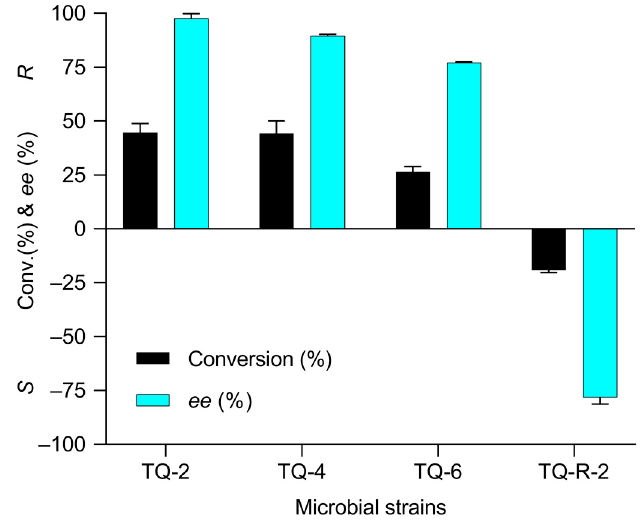
Figure 1. Microbial strains isolated from soil samples for selective reduction of acetophenone. Reaction conditions: 2 mM of acetophenone, 0.1 g/mL of wet cells, 24 h, 600 rpm. The alcohol products were analyzed by GC.